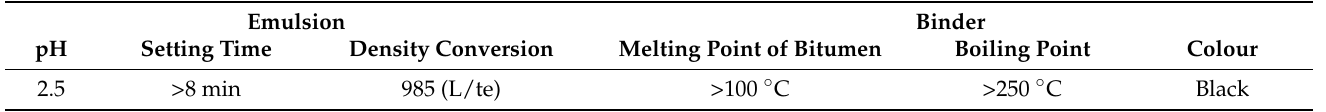
Table 3. Emulsion and binder